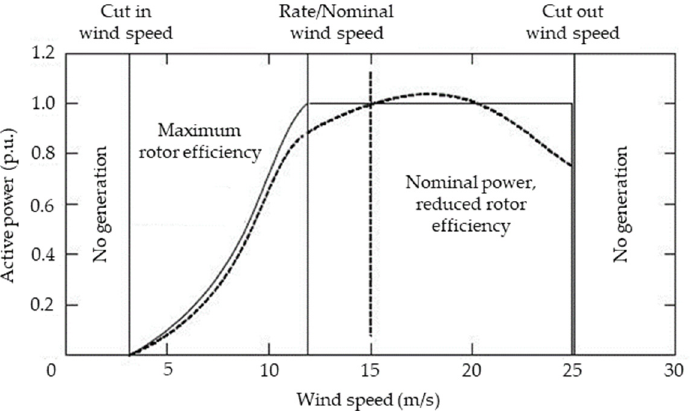
Figure 6. Wind speed levels in generating power output.